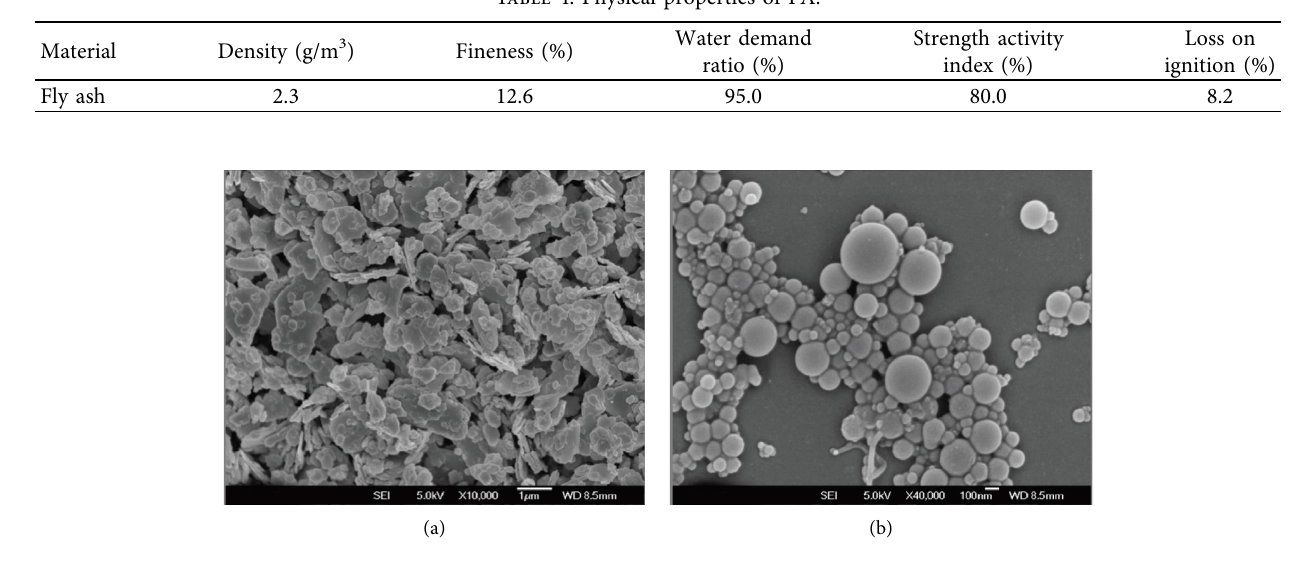
Figure 3: SEM images of (a) MK and (b) SF. Table 5: Mixture proportions of mortars.